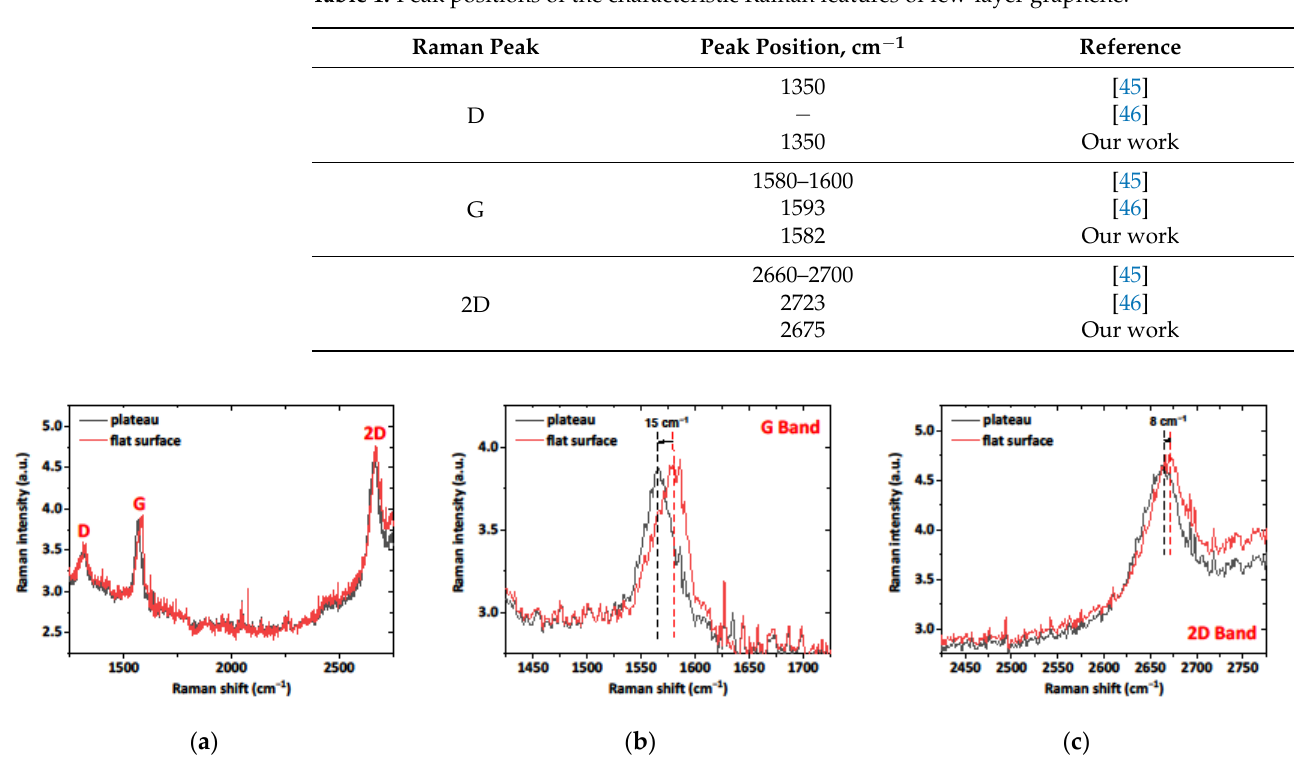
Table 1. Peak positions of the characteristic Raman features of few-layer graphene.